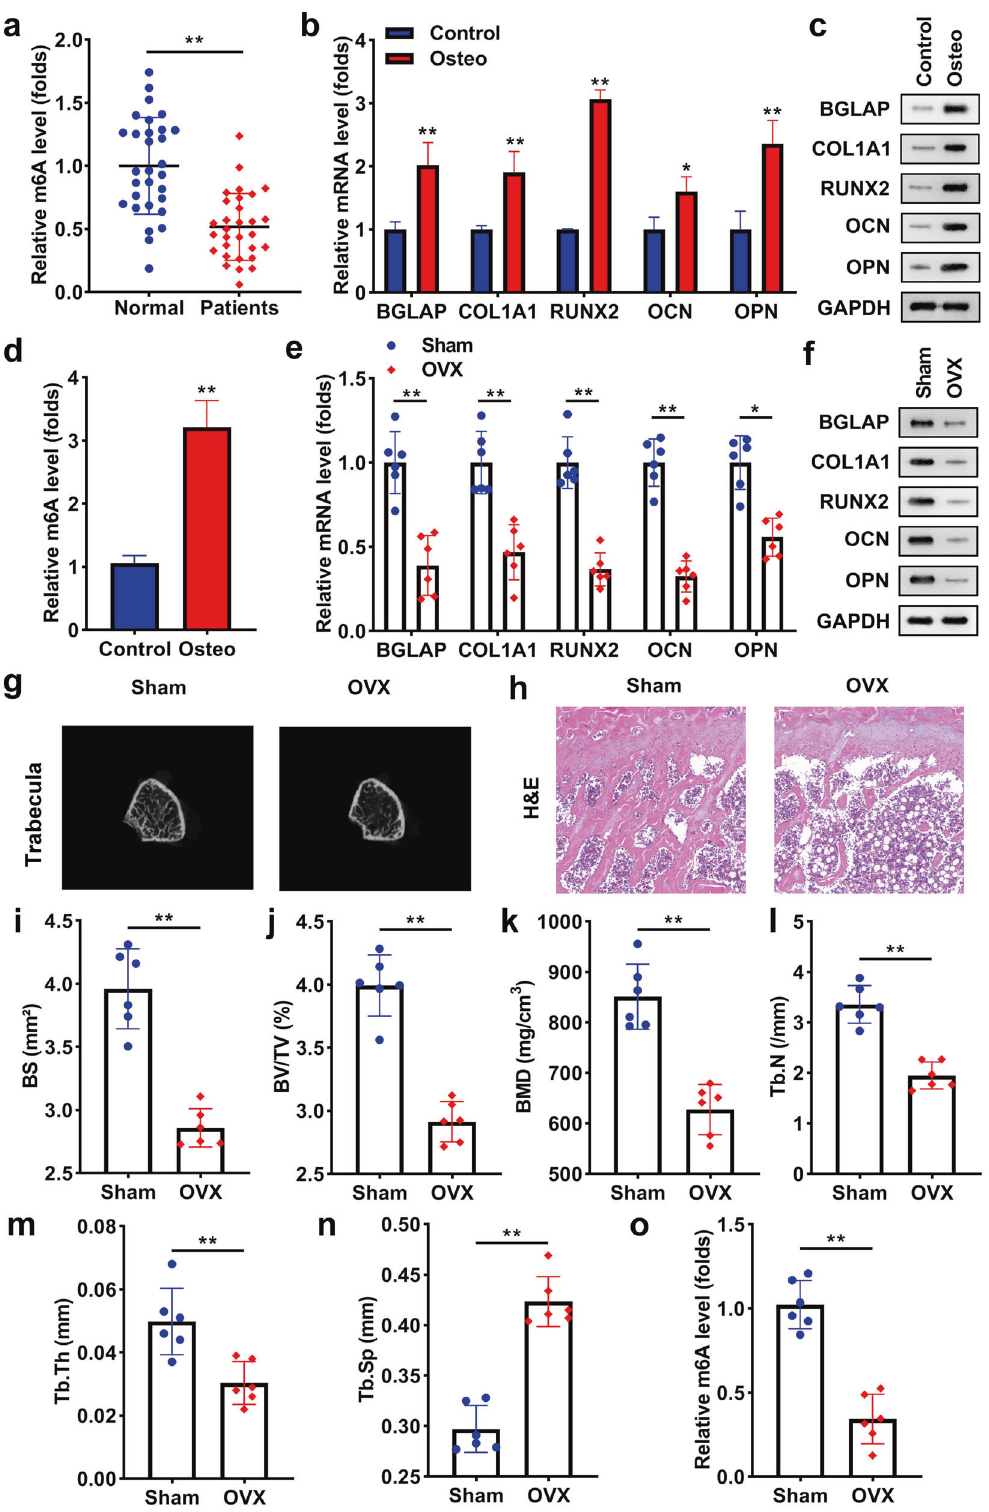
Fig. 1 M6A expression in patients with OP, osteogenic differentiated cells, and OVX mice. a m6A level in patients with or without OP (both n = 30). b The levels of BGLAP, COL1A1, RUNX2, OCN, and OPN were detected using qRT-PCR. c The protein levels of BGLAP, COL1A1, RUNX2, OCN, and OPN in the differentiated and undifferentiated BMSCs. d m6A level in osteoblast differentiated or undifferentiated cells. e The mRNA levels of BGLAP, COL1A1, RUNX2, OCN, and OPN were detected in mice of the sham and OVX groups. f The protein levels of BGLAP, COL1A1, RUNX2, OCN, and OPN in the sham and OVX mice. g Images of trabecular bone of mice. h Bone formation in mice was measured using the H&E assay and i BS was quanti fi ed. Bone formation index containing j BV/TV, k BMD, l Tb.N, m Tb.th, and n Tb.Sp were analyzed by μ -CT. o m6A levels in mice were tested using qRT-PCR. ** P < 0.01 and * P < 0.05.